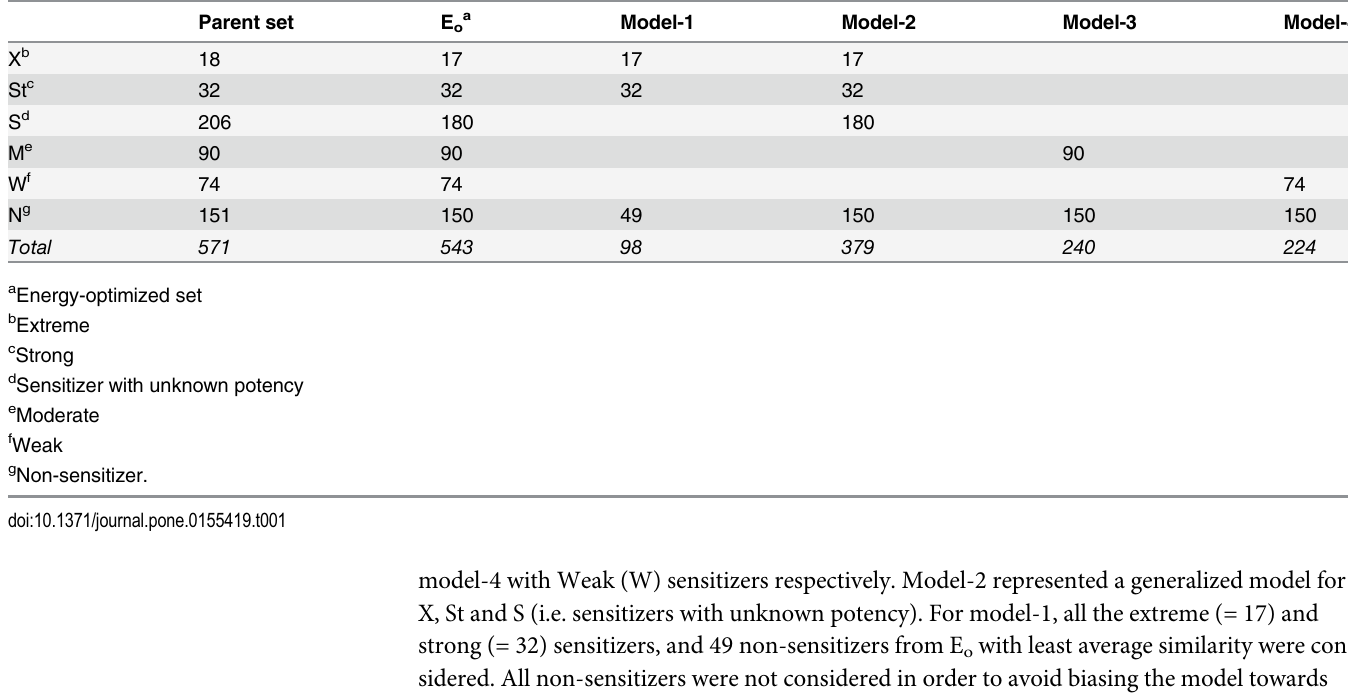
Table 1. Datasets used for building QSAR